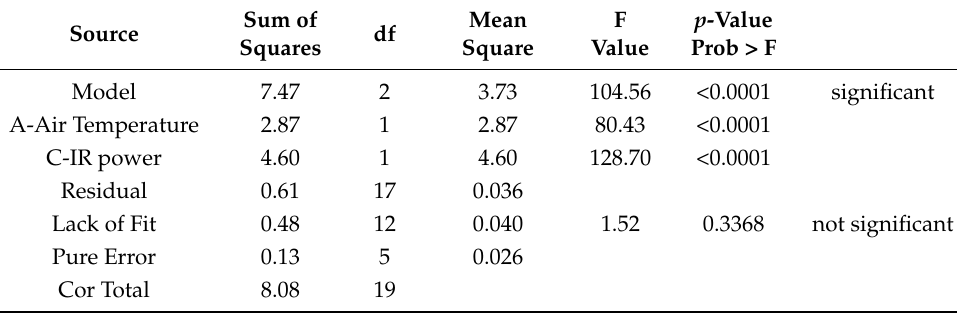
Table 12. Analysis of variance for TPC response using